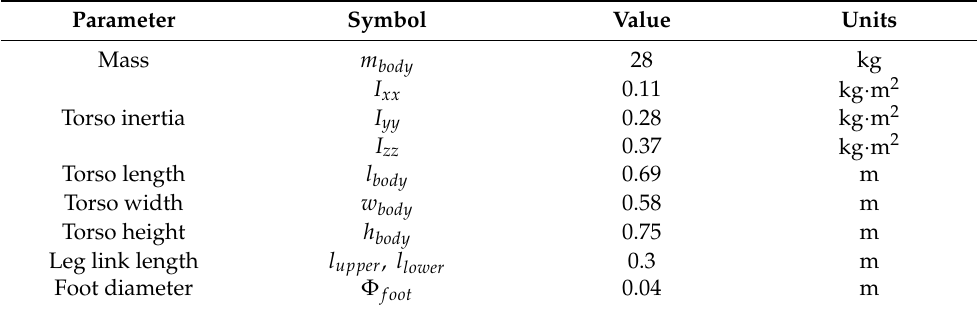
Table 2. Physical parameters of the robot.